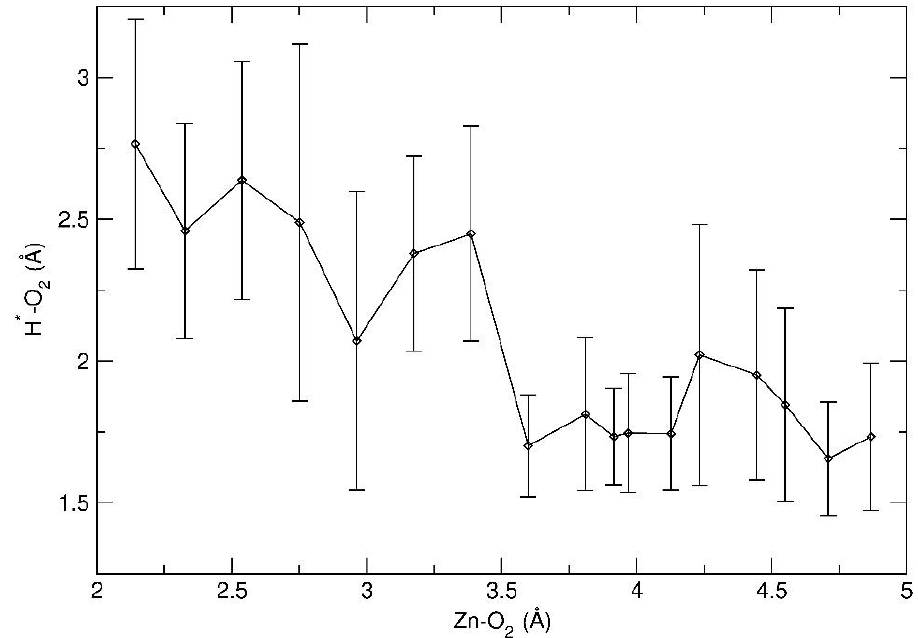
Figure 8. Variation of the average distance between the surface hydroxyl proton H* and the hfa oxygen O 2′ as a function of the Zn-O 2′ distance (reaction coordinate). Vertical bars represent the standard deviations, which are an estimate of the amplitude of the thermal oscillations of the O 2′ -H* distance. The black dots correspond to the BM-sampled values of the Zn-O 2′ distance.